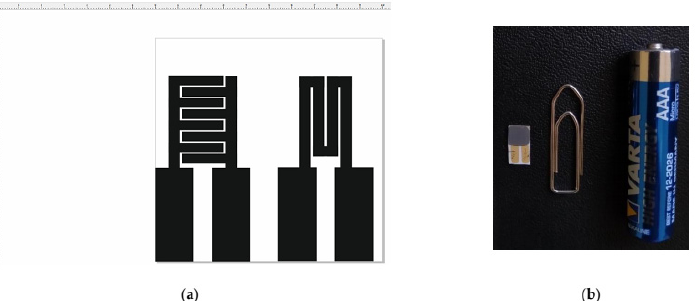
Figure 28. The new alumina transducer prototype measured at 5 × 10 × 0.6 mm: ( a ) platinum or gold IDE and platinum heater circuit-schematic representations; ( b ) actual sensor sample compared with various objects for sizing purposes, from Ref. [155].